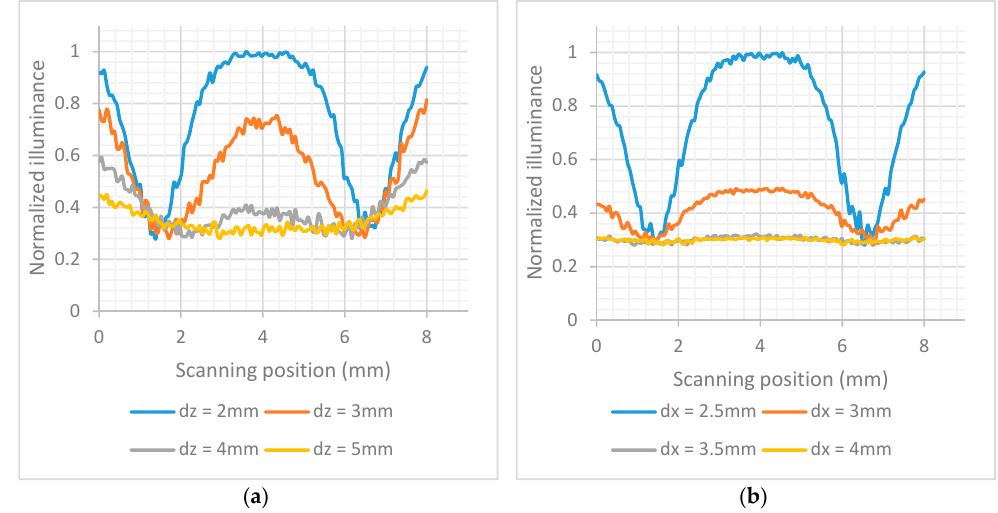
Figure 5. ( a ) Normalized illuminance across the array of photodiodes when the dz varies from 2 mm to 5 mm and three LEDs are used; ( b ) Normalized illuminance across the array of photodiodes when dx varies between 2.5 mm and 4 mm.